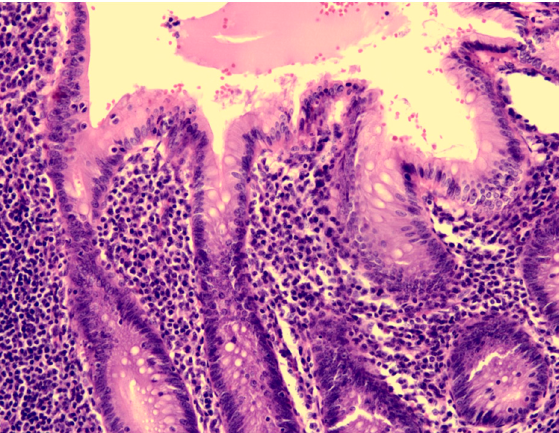
Figure 2. The muscularis layer of the appendix shows infiltration of acute inflammatory cells (arrow).